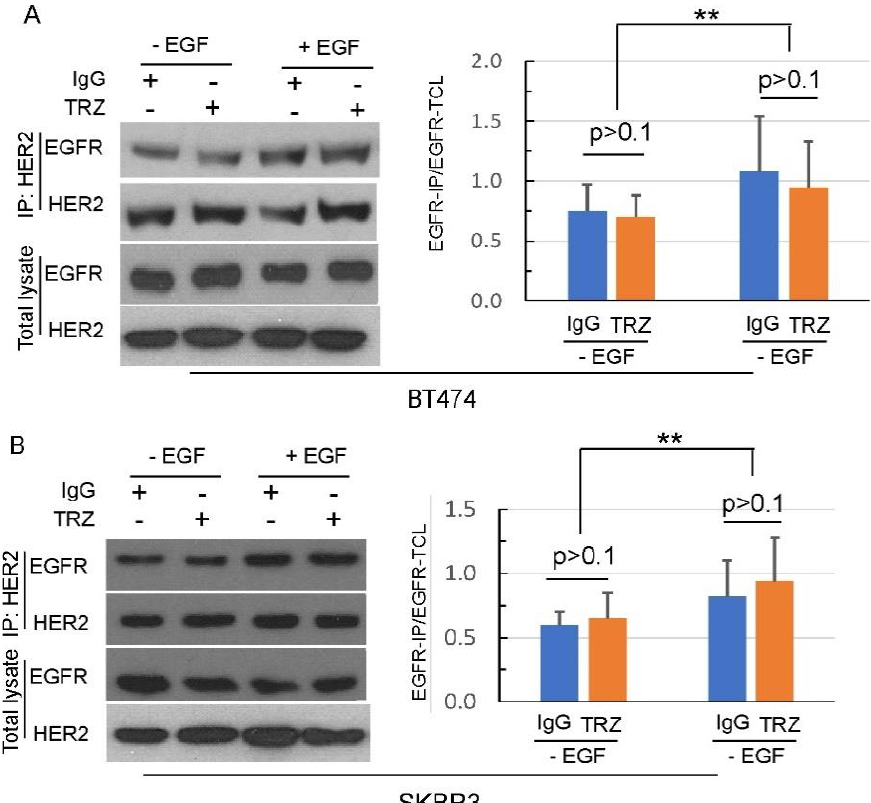
Figure 3. The effect of trastuzumab on HER2 heterodimer formation. The effect of trastuzumab at concentration of 10 µ g/mL on HER2–EGFR and HER2–HER3 heterodimers in BT474 ( A ) and SKBR3 ( B ) breast cancer cells for 1 h. HER2–EGFR and HER2–HER3 heterodimer formation was assessed in the presence and absence of EGF and HRG α at 50 ng/mL, respectively. The expression of HER receptors in both IP and total cell lysate (TCL) samples was revealed by immunoblotting. HER2 receptors were precipitated using HER2-specific antibody as primary antibody, followed by immunoblotting with the indicated antibodies. Cells treated with normal human IgG were used as negative control. **: p <